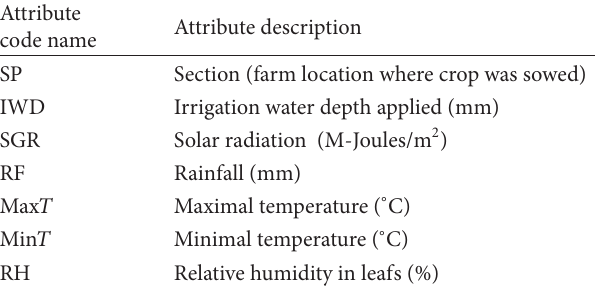
Table 1: Potential attributes in crop